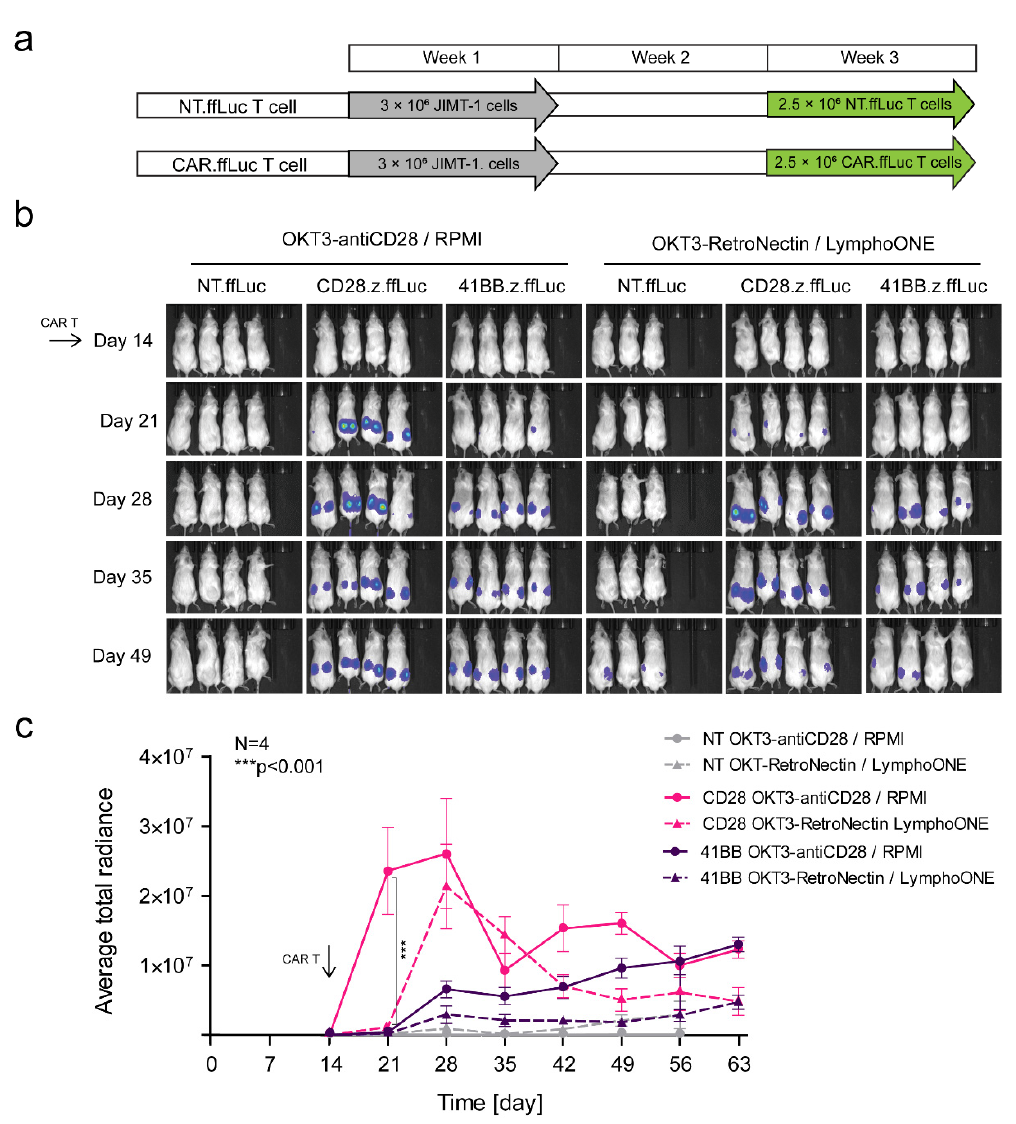
Figure 6. EM-enriched CD28.z CAR.ffLuc T cells expand within one week post-infusion at tumor xenograft sites in vivo. Mice were injected s.c. with 3 × 10 6 JIMT-1 cells. Mice on day 14 (arrow) received a single i.v. dose of 2.5 × 10 6 NT.ffLuc T cells (NT.ffLuc OKT3-antiCD28/RPMI T cells, n = 4, grey, straight line; NT.ffLuc OKT3-RetroNectin/LymphoONE T cells, n = 3, grey, dashed line) or a single i.v. dose of 5 × 10 6 HER2-CAR.ffLuc T cells (CD28.z.ffLuc OKT3-antiCD28/RPMI T cells, n = 4, pink, straight line; CD28.z.ffLuc OKT3-RetroNectin/LymphoONE T cells, n = 4, pink, dashed line; 41BB.z.ffLuc OKT3-antiCD28/RPMI T cells, n = 4, purple, straight line; 41BB.z.ffLuc OKT3-RetroNectin/LymphoONE T cells, n = 4, purple, dashed line). Tumor infiltration was followed by bioluminescence imaging. ( a ) Outline of the treatment schedule. ( b ) Representative images of JIMT-1-injected animals. ( c ) Quantitative bioluminescence imaging data of HER2-CAR.ffLuc T cells infiltrating JIMT-1 xenografts (average total radiance = photons/s/cm2/sr; CD28.z.ffLuc OKT3-antiCD28/RPMI HER2-CAR vs. CD28.ffLuc OKT3-RetroNectin/LymphoONE HER2-CAR.ffLuc: *** p < 0.001) Histograms represent mean ± SD.